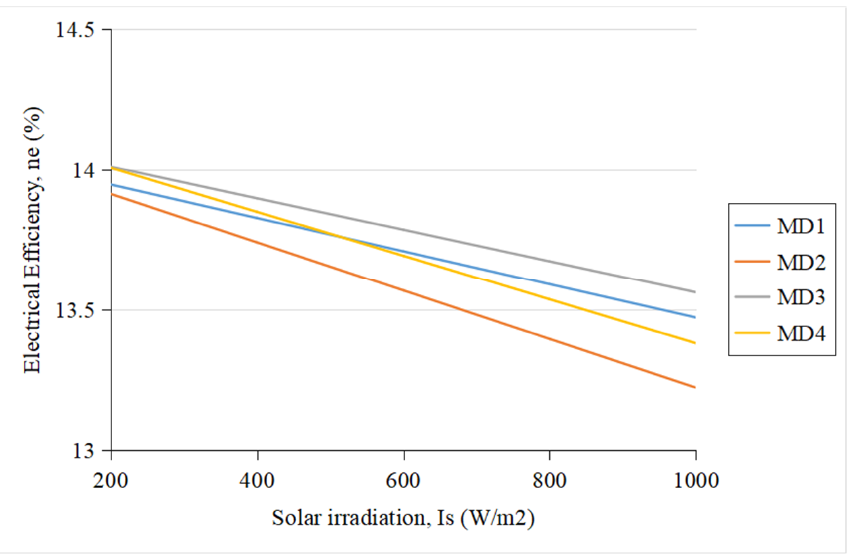
Figure 18. Electrical efficiency of four models of PV/T modules when changing solar radiation in- tensity.